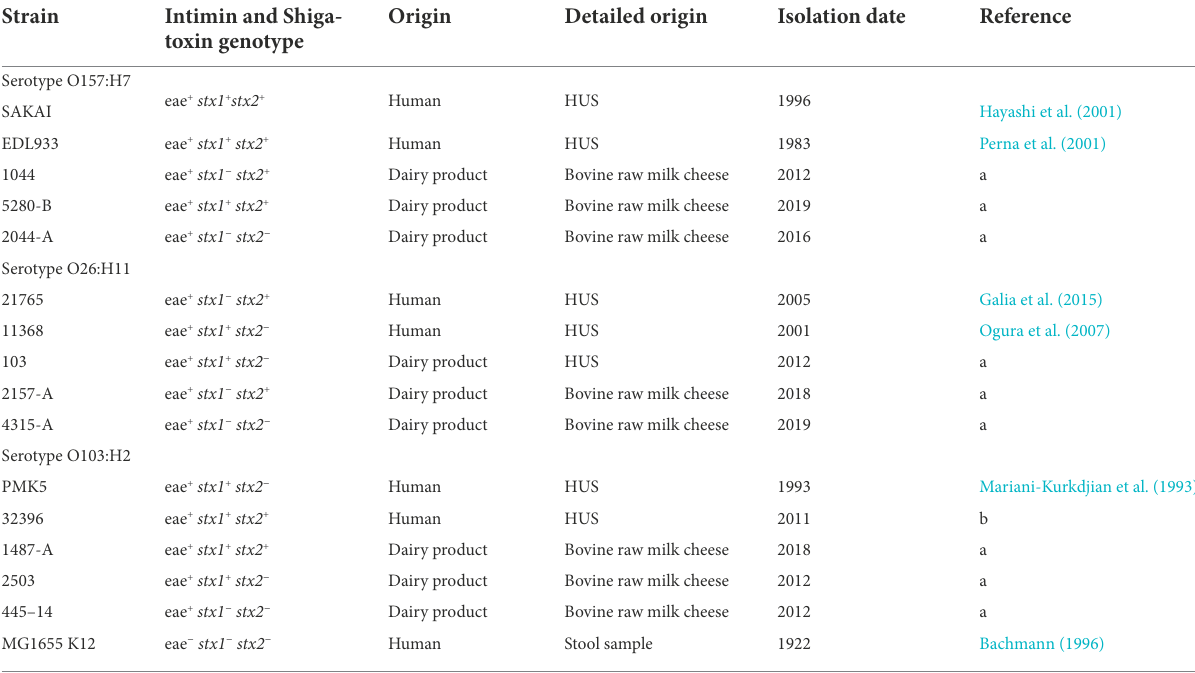
TABLE 1 Collection of 16 E. coli strains used in the study, included O157 and non-O157 strains: O157:H7 ( n = 5), O26:H11 ( n = 5), O103:H2 ( n = 5), and the non-pathogenic E. coli K-12 str. MG1655. Strain Intimin and Shiga- toxin